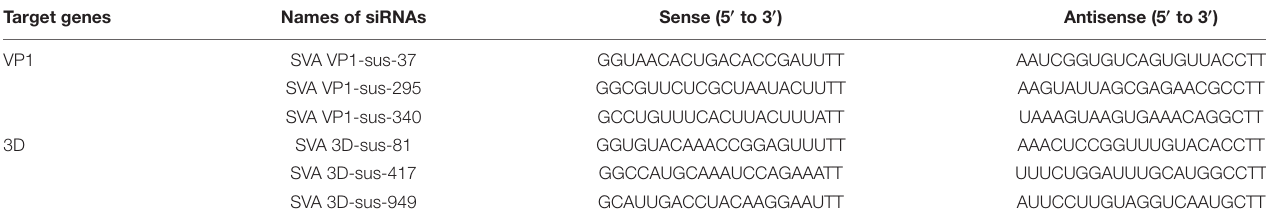
TABLE 2 | Sequence of siRNAs test in this study. Target genes Names of